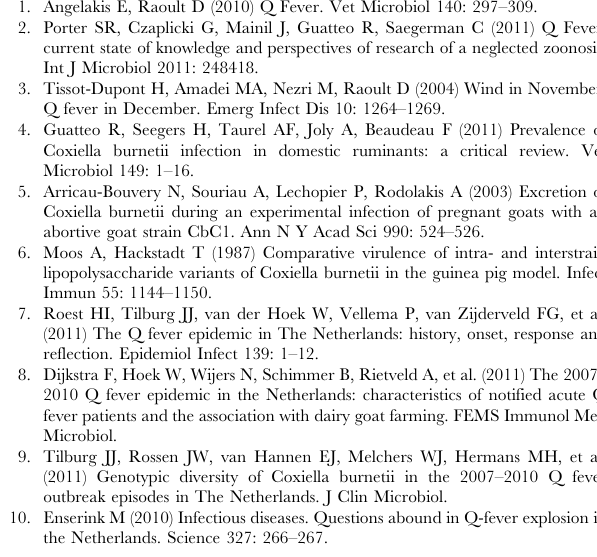
Figure S1 Schematic representation of the protocol used for in vivo infection in BALB/c mice. 6- week old